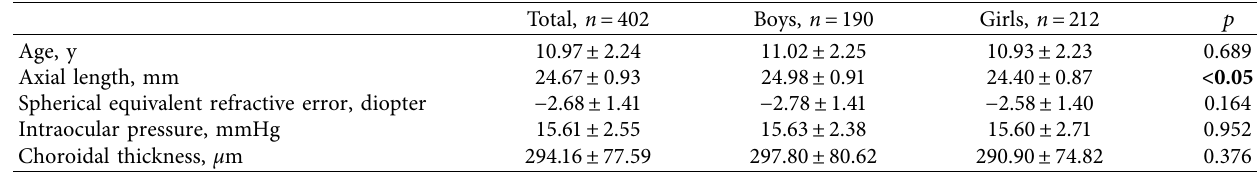
Figure 1: An example of measurement of choroidal thickness along the center line (Cf). Choroidal thickness was measured from the retinal pigment epithelium to the choroidal-scleral junction at 0.5 mm intervals. Table 1: Demographic information of 402 myopic children.